Question: What direction does the quantity move in — increasing or decreasing?
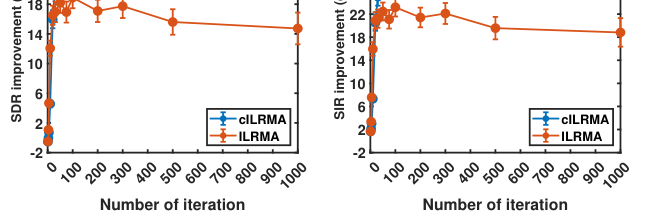
Answer: increasing